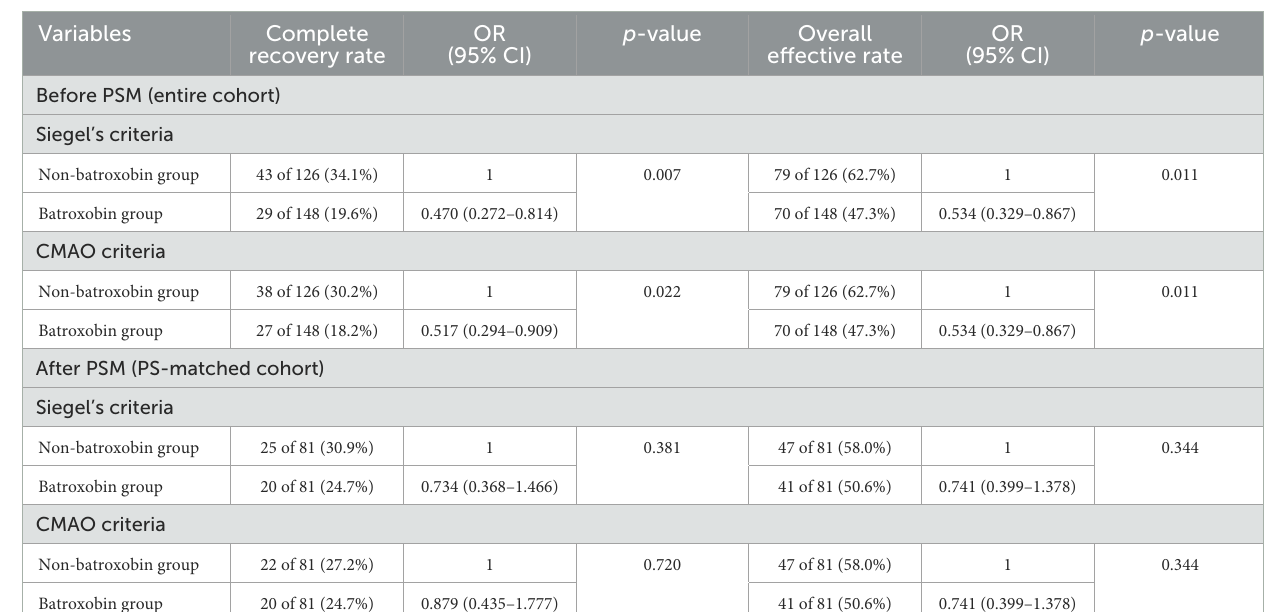
TABLE 2 Complete recovery rate and overall effective rate before and after propensity score matching in the